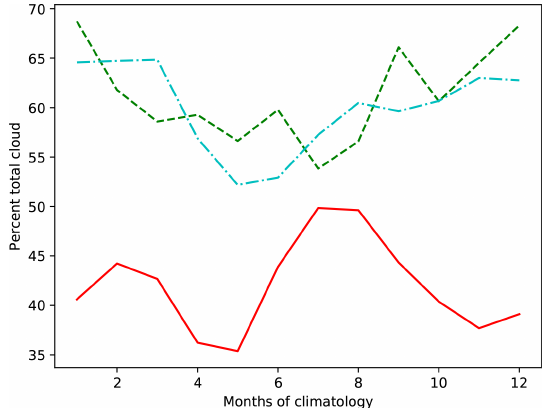
Figure 7. Climatological monthly averages of total clouds over the GrIS region for CESM (red), ISCCP (Rossow and Schiffer, 1999) (green), and CLOUDSAT (Kay and Gettelman, 2009)